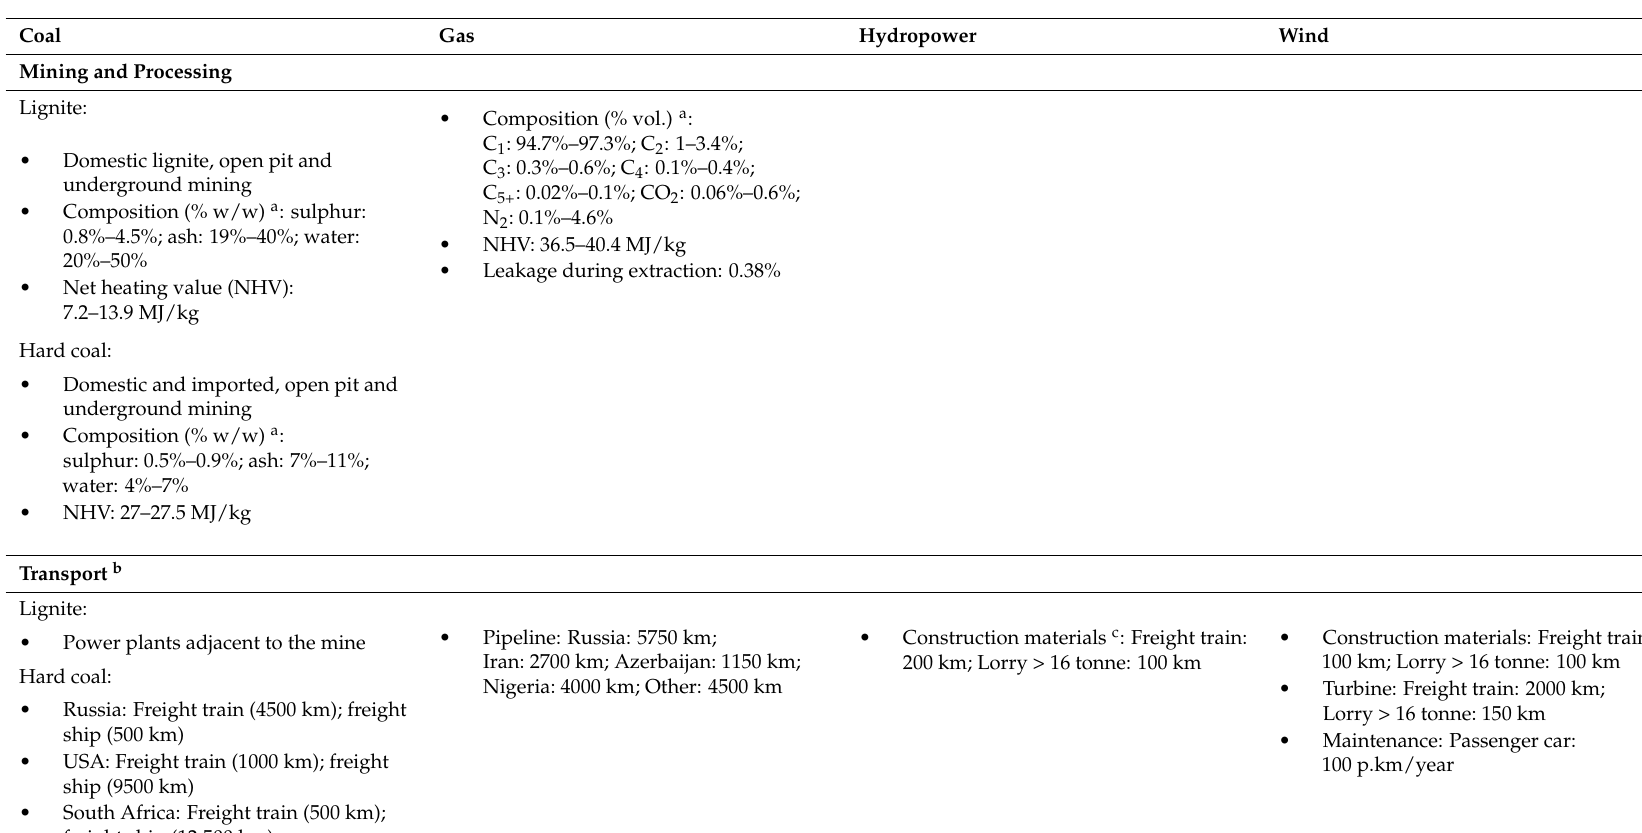
Table 4. Assumptions and summary of inventory